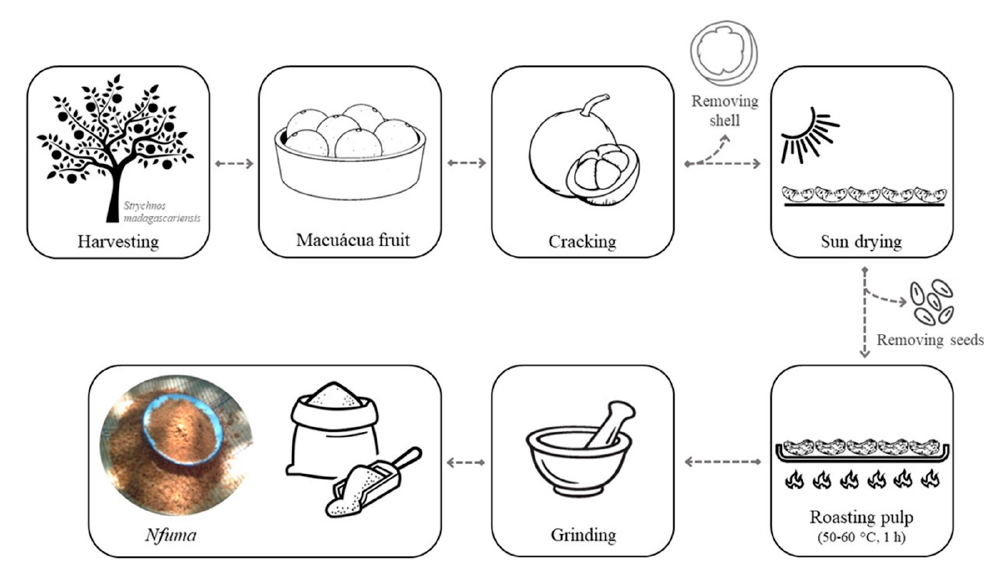
Figure 1. Schematic description of the preparation of nfuma by Mozambican communities: from the fruit of Strychnos madagascariensis to flour.